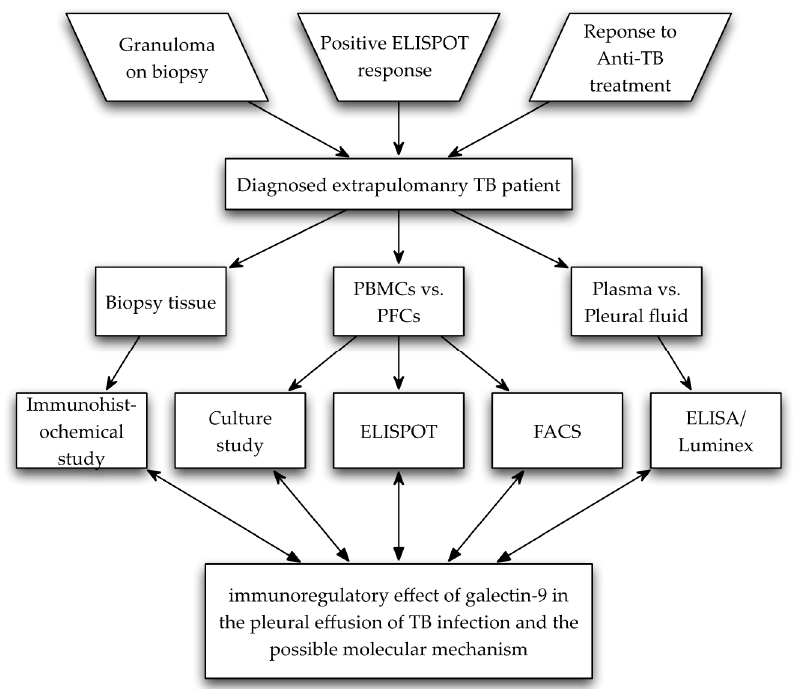
Figure 7. Diagram outline of subject selection, study methods, and purpose of this study.